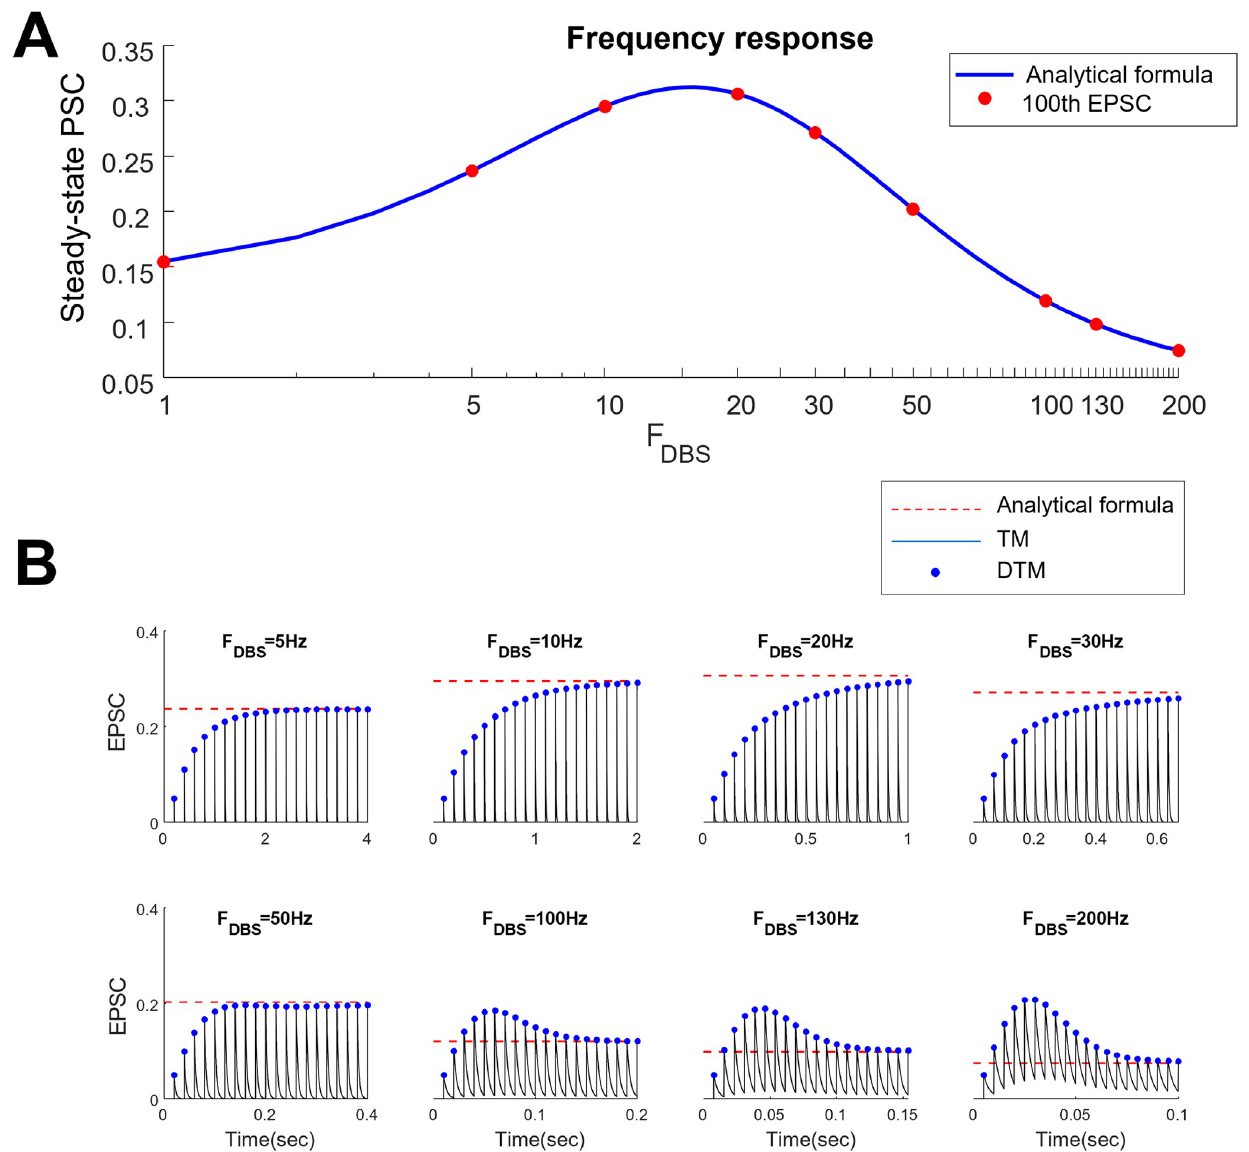
Fig 1. Steady-state responses of postsynaptic current (PSC) in response to different stimulation frequencies. A) The steady-state value of PSCs calculated by the analytical formula (blue line) accurately fits to the steady-state responses (red dots) of the discrete TM model (calculated for the 100 th stimulation pulse). B ) An example of PSC in response to 1, 5, 10, 20, 30, 50, 100, 130, 200 Hz stimulation pulses. The red dashed line represents the steady- state value of PSCs calculated from analytical solution (see methods). The black plot shows the time trace of postsynaptic PSC in response to the stimulation calculated from the TM model. The blue dots represent the local peaks of the PSC calculated from discrete TM model. Each panel shows the response of PSC to 30 stimulation pulses at different frequencies. The steady-state values of both TM and discrete TM models converge to those obtained by analytical